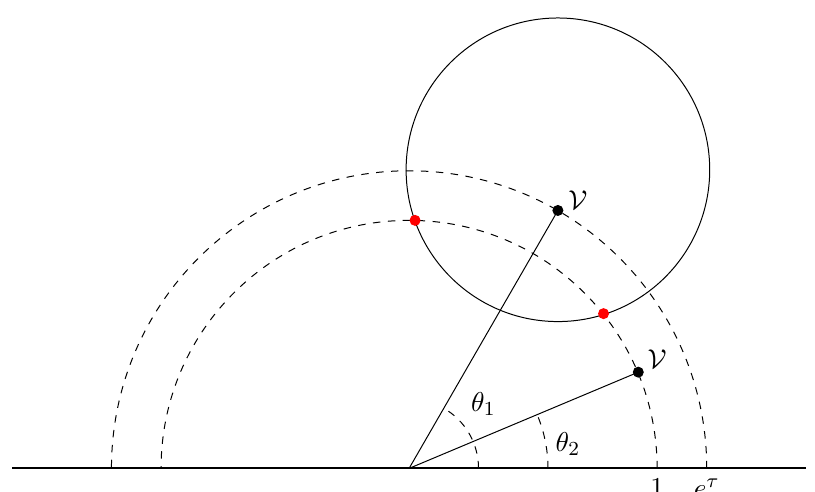
Figure 37. The dashed semi-circles are constant global time surfaces. The solid circle is a surface of fixed geodesic distance from the V insertion at angle θ The δ function in eq. (C.11) has support at the location of the two red